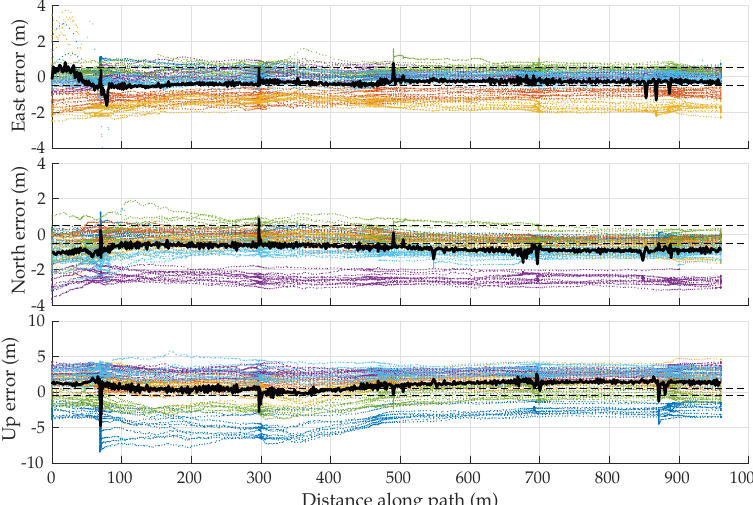
Figure 14. Errors in ublox M8T position estimates with respect to ground truth in the east, north, and up directions. Different colors distinguish data from six different campaigns. Dashed reference lines are drawn at ± 50 cm. The solid black lines show the mean positioning error over the six campaigns. The error standard deviation in the east is ∼ 1.5 m over the first 100 m along the path and ∼ 0.7 m over the rest; ∼ 0.9 m in the north; and ∼ 2.7 m over the first 400 m and ∼ 2 m over the rest in the up